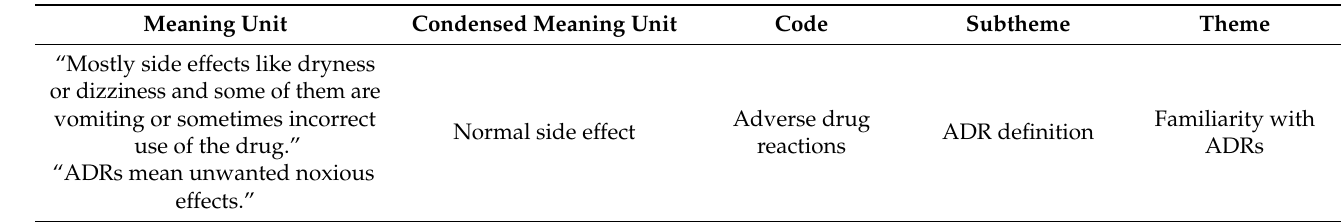
Table 2. Example of coding process.